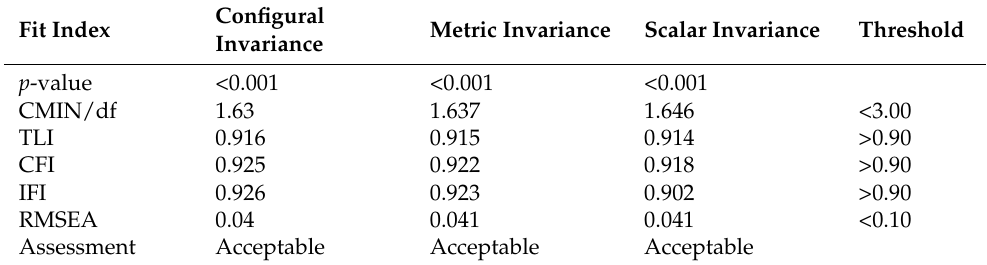
Table 10. Measurement